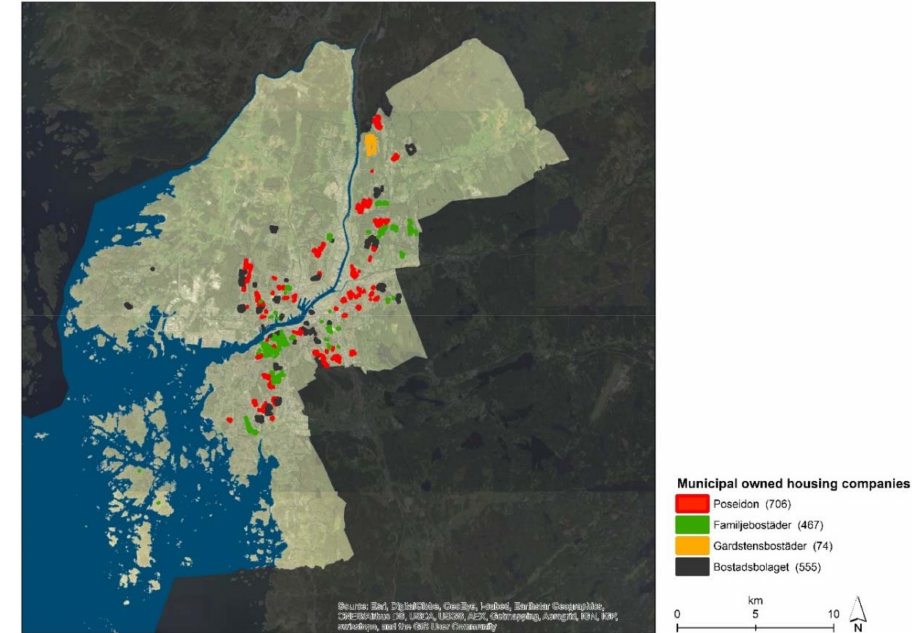
Figure 7. Spatial distribution of ownership for the four subsidiaries of the municipal housing company Framtiden AB. In brackets is the number of managed buildings per company. Numbers in brackets indicate number of